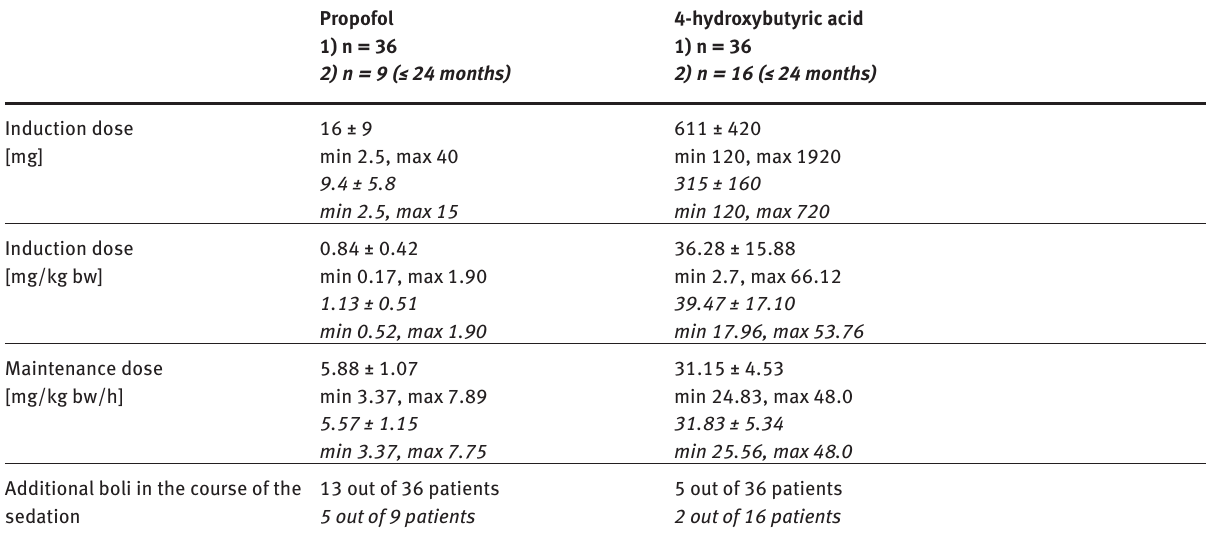
Induction dose = administration of boli in addition in addition to the initial dose via perfusor as described in table 1 AV = average; SD = standard deviation; min = minimum; max = maximum bw = body weight Results in Propofol or 4-hydroxybutyric acid column as AV ±